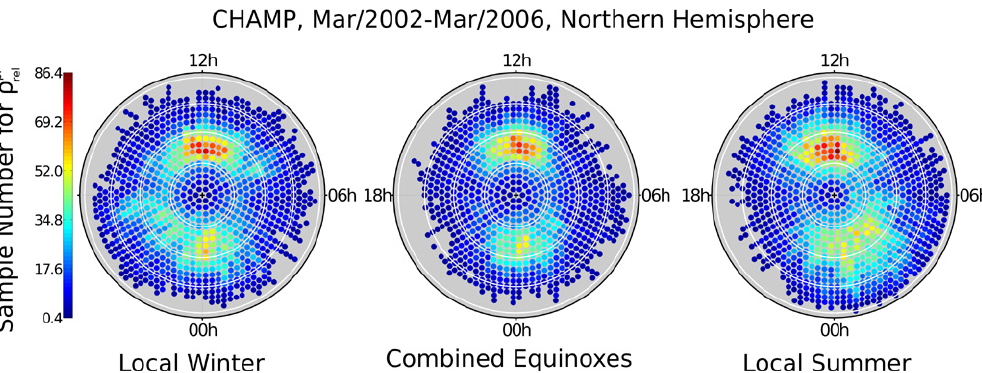
Fig. 5. Sample number distribution per bin for ρ pr normalized by the number of passes over that bin is shown for the three local seasons: rel winter (left column), combined equinoxes (middle column), and summer (right column). The white circles mark the MLat at 10 ◦